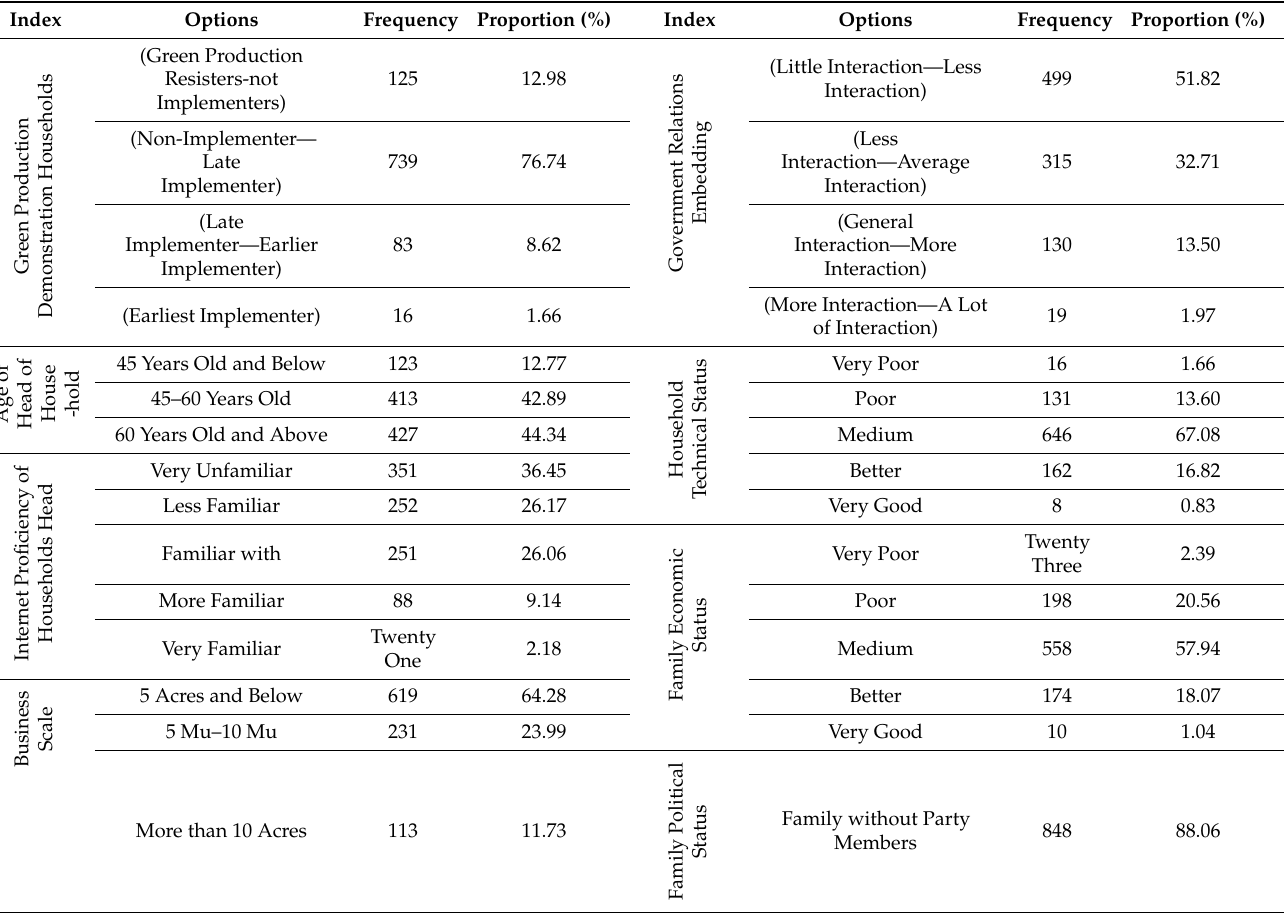
Table 3. Basic Characteristics of Sample